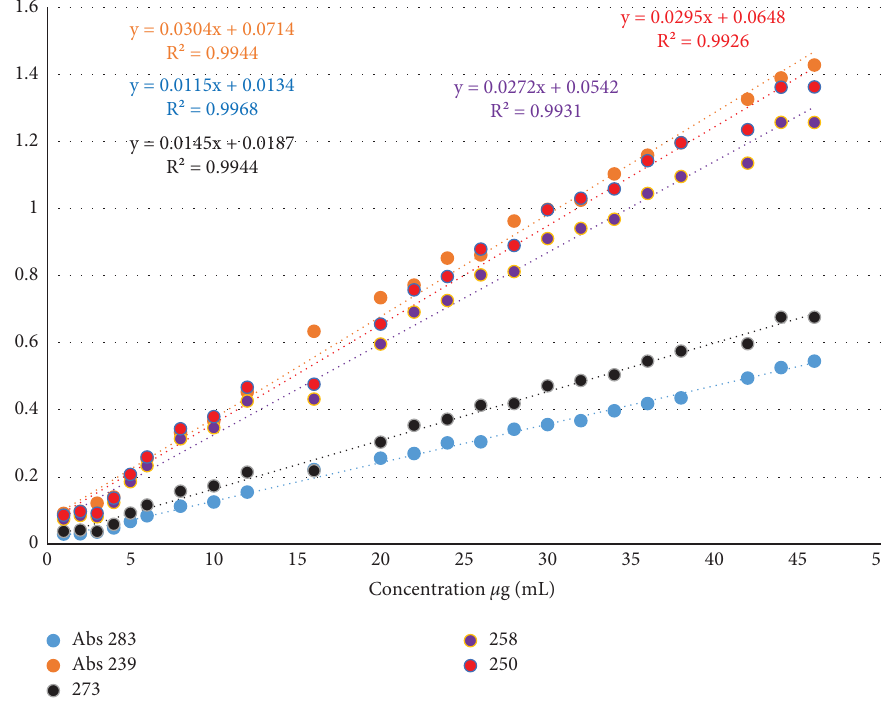
Figure 4: Calibration graph of candesartan cilexetil at 283, 273, 258, 250, and 239nm.